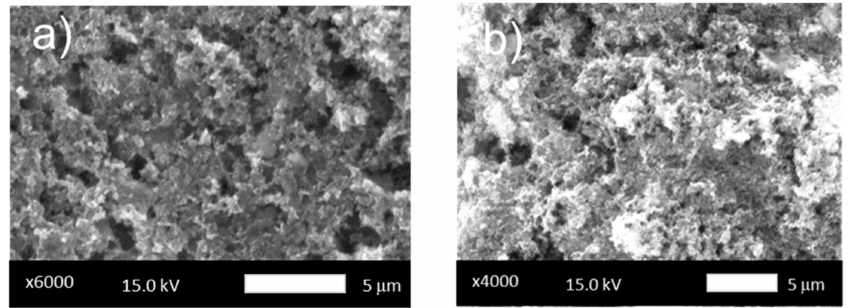
Figure 7. The SEM images of ( a ) pre-cycling and ( b ) post-cycling the Ni(dto)-DH/C electrodes. The elemental analysis of post-cycling electrodes was conducted using an EDX spec- trophotometer equipped with the dry silicon drift detector. In the energy range of 0–12 keV, peaks related to N, O, S, Ni, and K elements were found with the atomic ratio of Ni:O (29.6%:55.82%), corresponding to